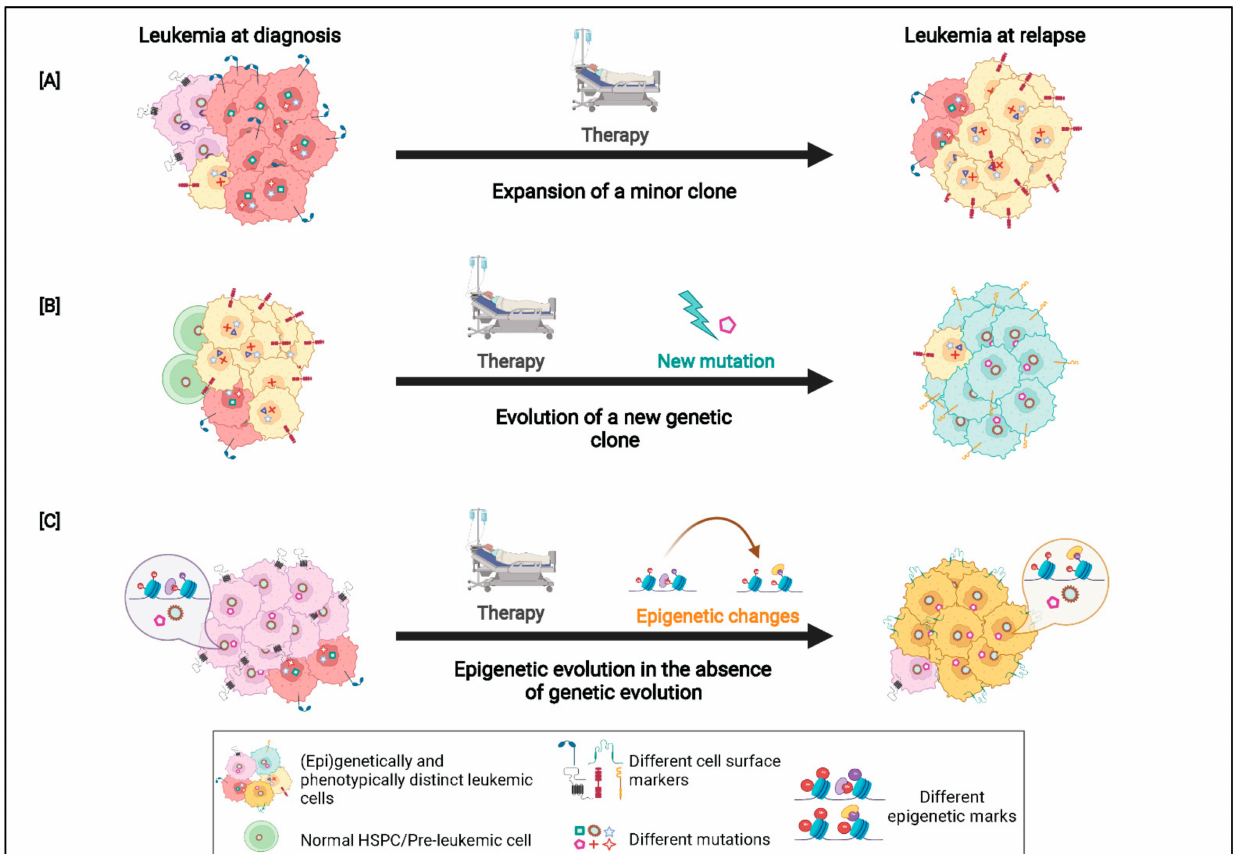
Figure 4. Genetic, phenotypic and epigenetic evolution in AML: ( A , B ) On applying a selective extrinsic pressure (e.g., chemotherapy), the leukemia undergoes genetic evolution. The dominant clone at diagnosis may be lost or considerably reduced in the relapse sample, with either a minor clone at diagnosis expanding at relapse ( A ) or, due to the acquisition of new mutations, a new subclone might appear at relapse ( B ). In both instances, the new dominant clone at relapse may have a different cell surface expression profile compared to the major clone at diagnosis, thus resulting in an immunophenotypic shift of the leukemia. ( C ) In some cases, a change in the leukemic phenotype is observed between samples at diagnosis and relapse, although no changes in the genetic clonal composition is observed. There is now evidence that in such cases changes in the epigenomic landscape of the leukemia might be responsible for driving disease progression and